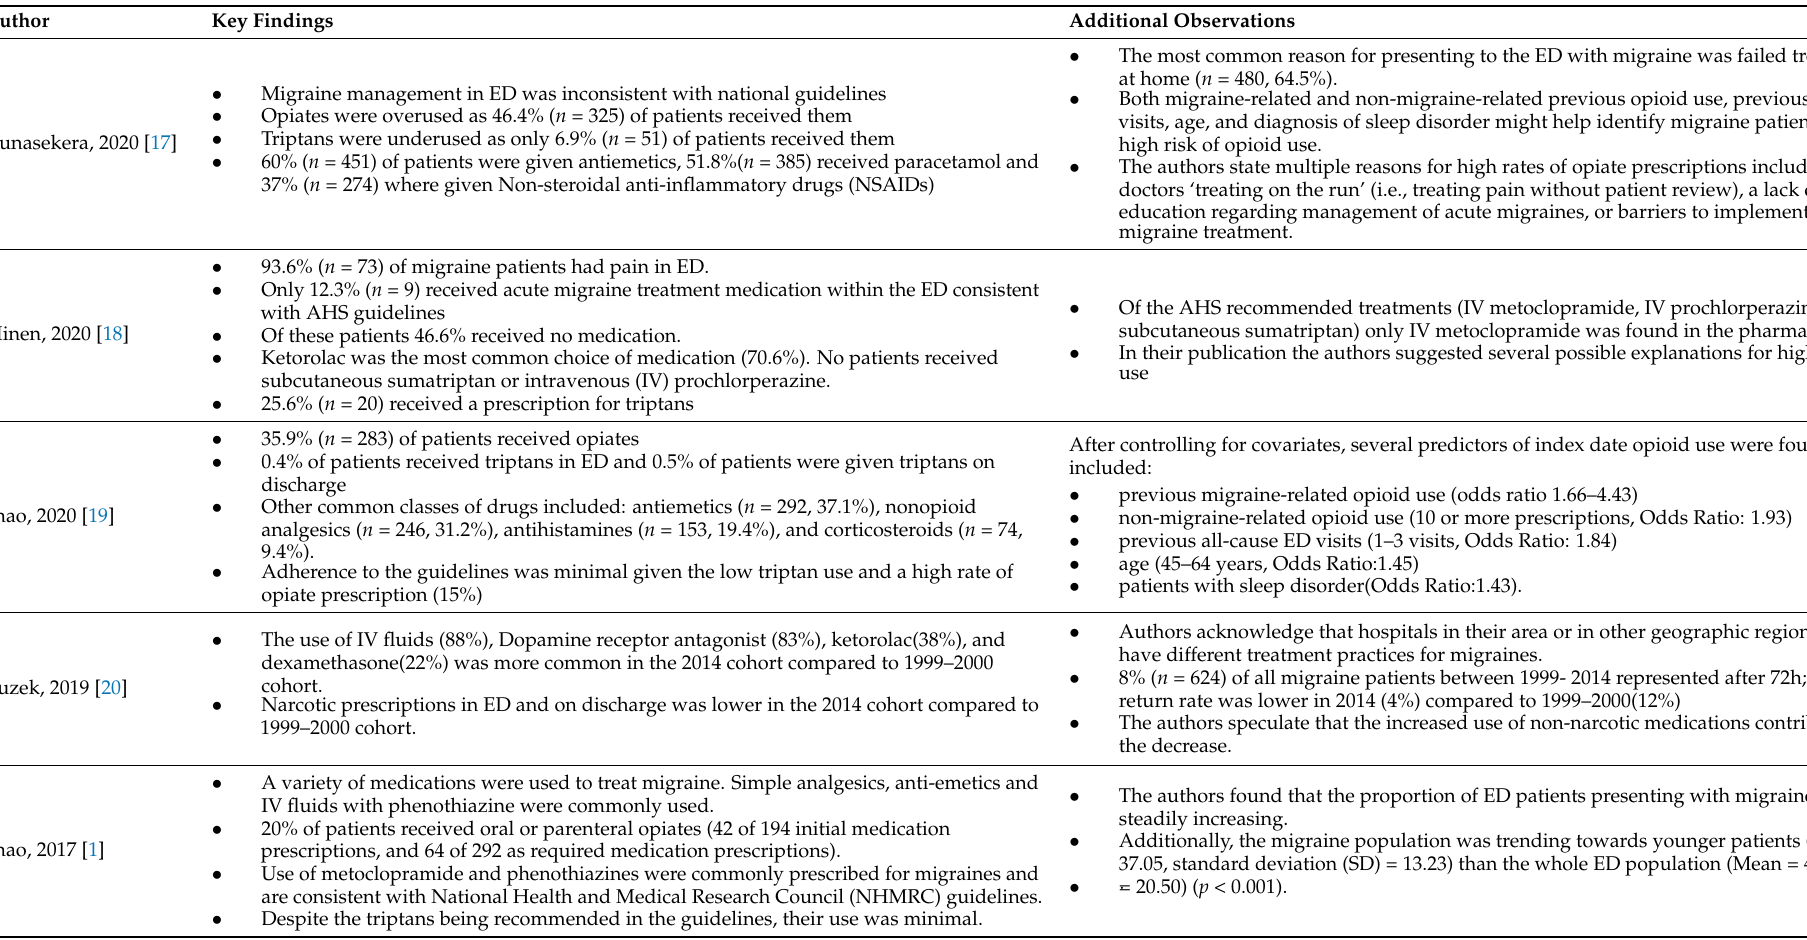
Table 2. Key findings and additional observations of included